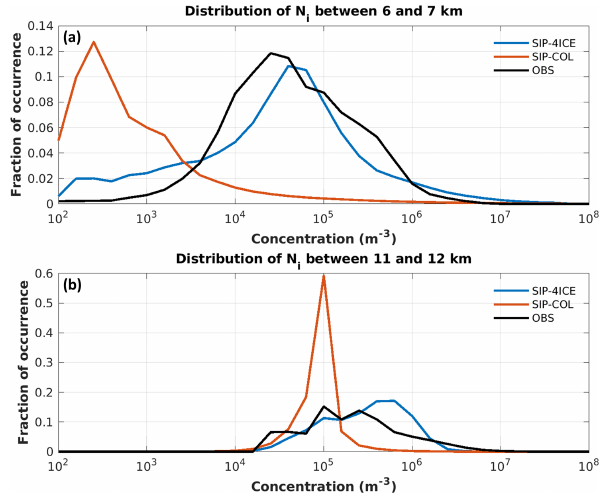
Figure 20. Similar to Fig. 8 but for SIP-4ICE and SIP-COL.